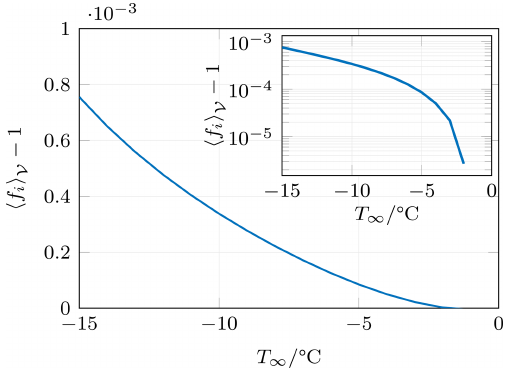
Figure 9. Global ice enhancement factor as a function of cloud tem- perature. The inset shows the same data but on a semi-logarithmic